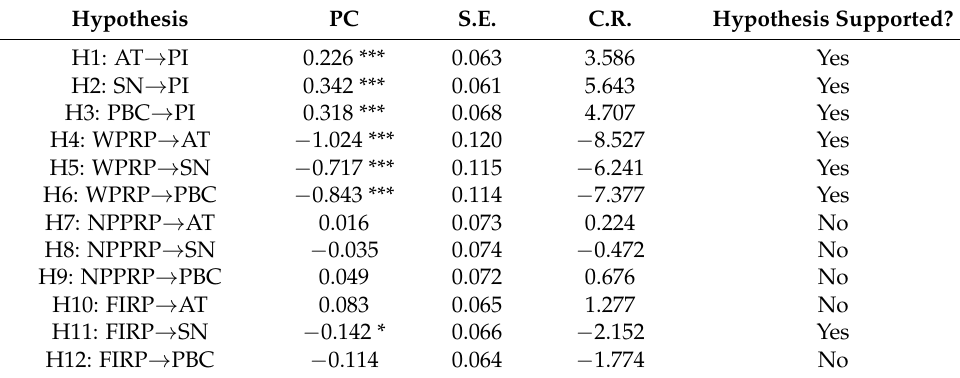
Table 5. Results of structural equation